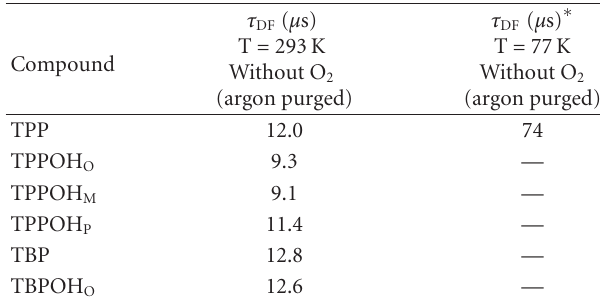
Table 2: Fluorescence lifetime, τ S , for the series of unsymmetrically substituted mesoporphyrin compounds in benzene and in the presence of oxygen (air equilibrated samples) and in the absence of oxygen (argon purged samples).